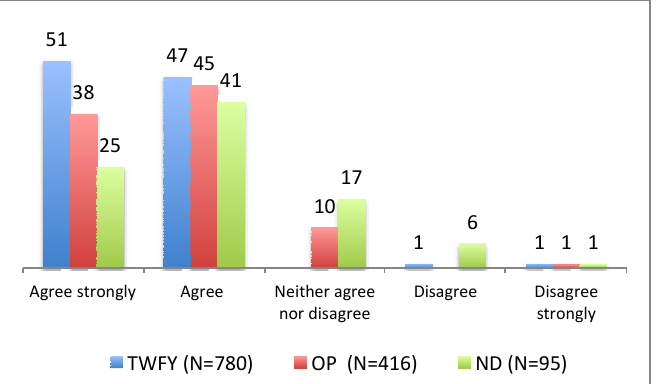
Figure 4. How much do you agree or disagree with the following statement? “(The